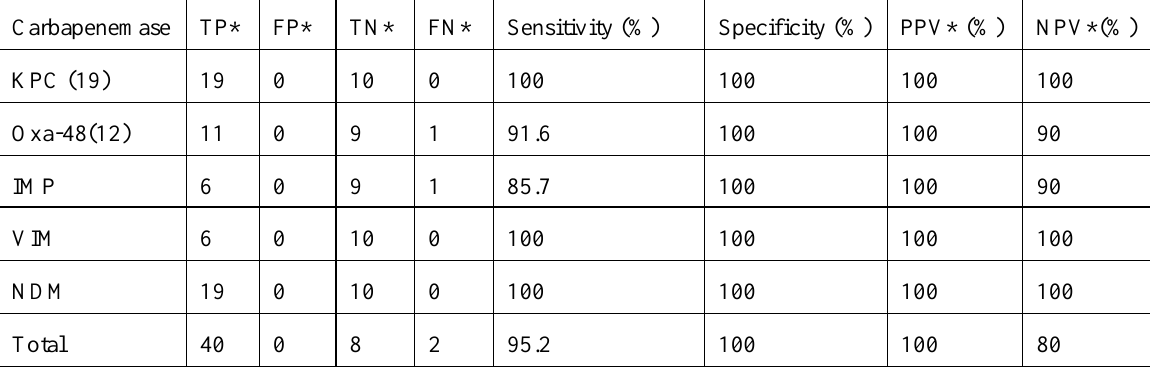
Table 4. Performance parameters of direct CNPt as a screening test.